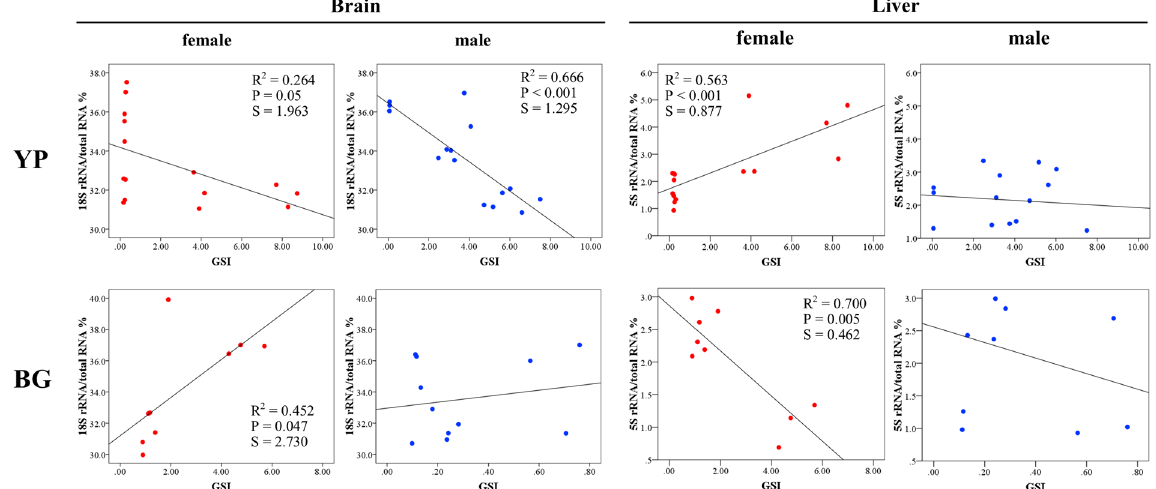
Figure 5. Dynamic variation of ribosome RNA (rRNA) with gonad development in brain and liver of yellow perch (YP) and bluegill (BG). GSI, gonadosomatic index. S, standard error of the